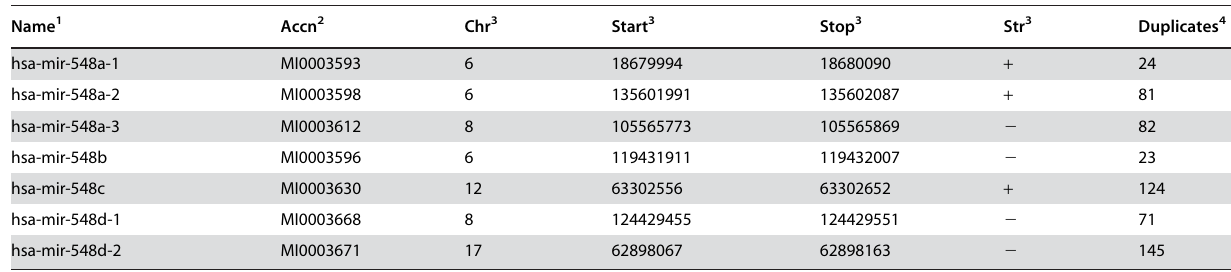
Table 1. Made1 derived miRNA genes in the human genome .. ... .... ... ... .... ... ... .... ... ... .... ... ... .... ... ... .... ... ... .... ... ... .... ... ... .... ... ... .... ... ... .... ... ... .... ... ... .... ... ... .... ... ... . Name 1